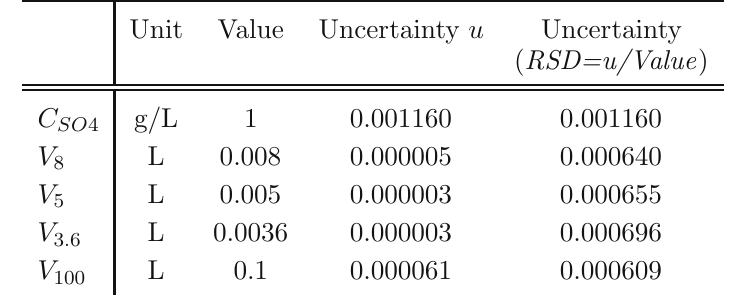
Table 2 Uncertainty components and their relative standard uncertainty of sulphate working reference